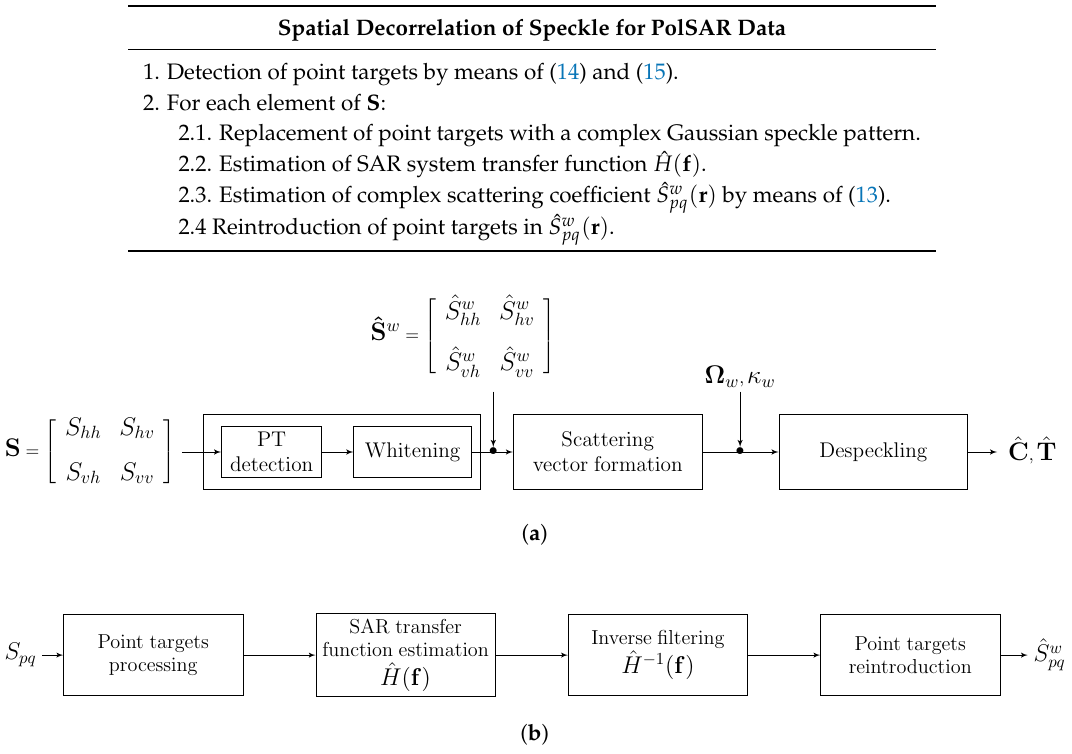
Figure 1. PolSAR spatial decorrelation processing and despeckling. ( a ): whole processing chain; ( b ): close-up of whitening